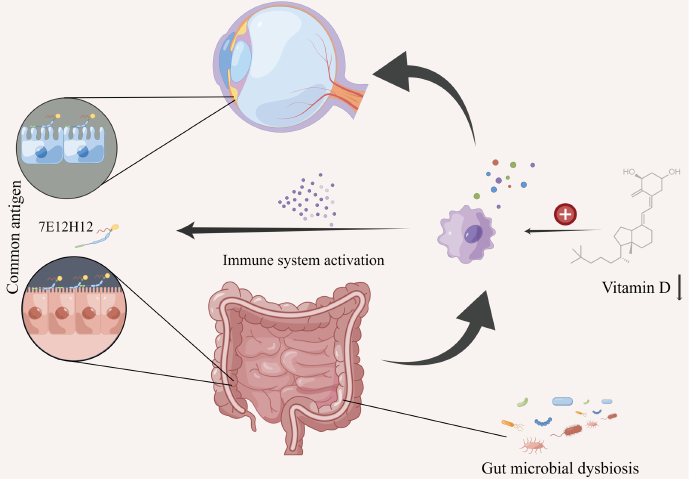
Figure 5. The possible mechanisms of iridocyclitis in inflammatory bowel disease. Different mecha- nisms, including shared peptide (common antigen), Vitamin D deficiency, and gut microbial dysbiosis could be involved. All of the mechanisms are immune-mediated, although other mechanisms may also